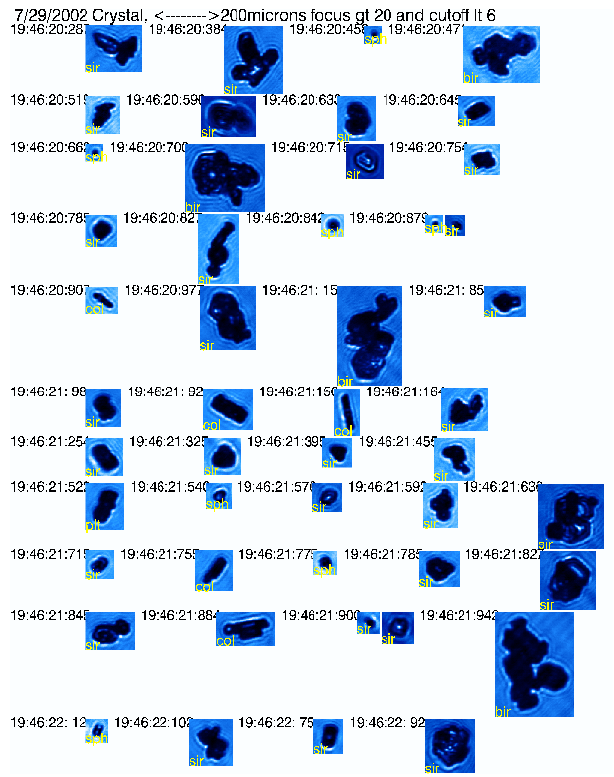
Fig. 5. Typical CPI images taken in the 29 July case on the